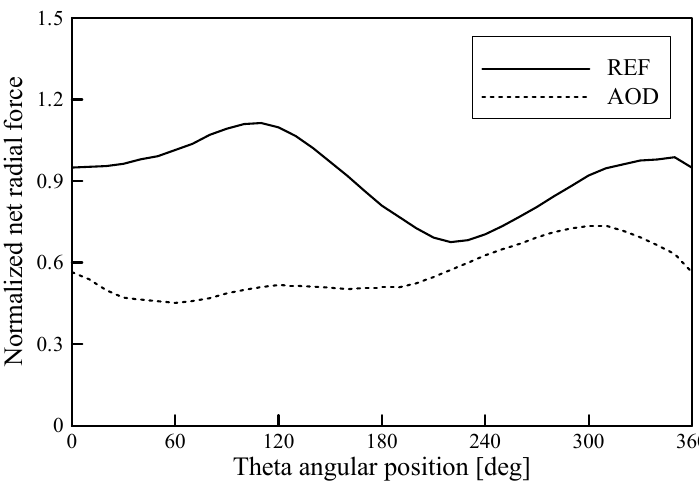
Figure 16. Unsteady net radial force fluctuations during one rotation of impeller.